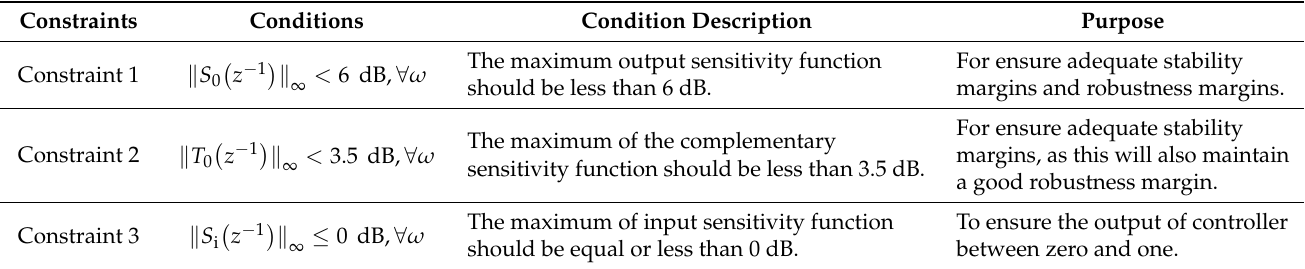
The maximum of input sensitivity